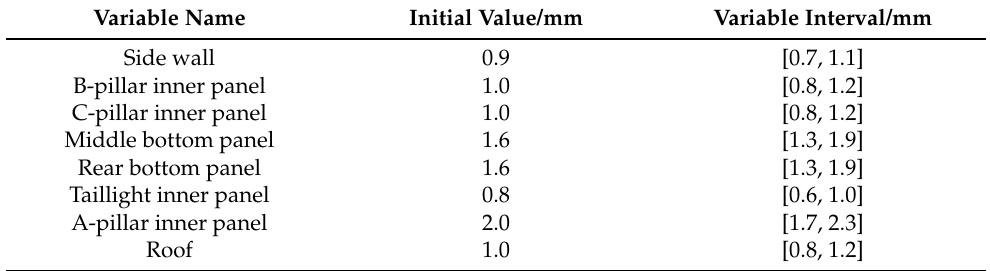
Table 3. Value ranges of the